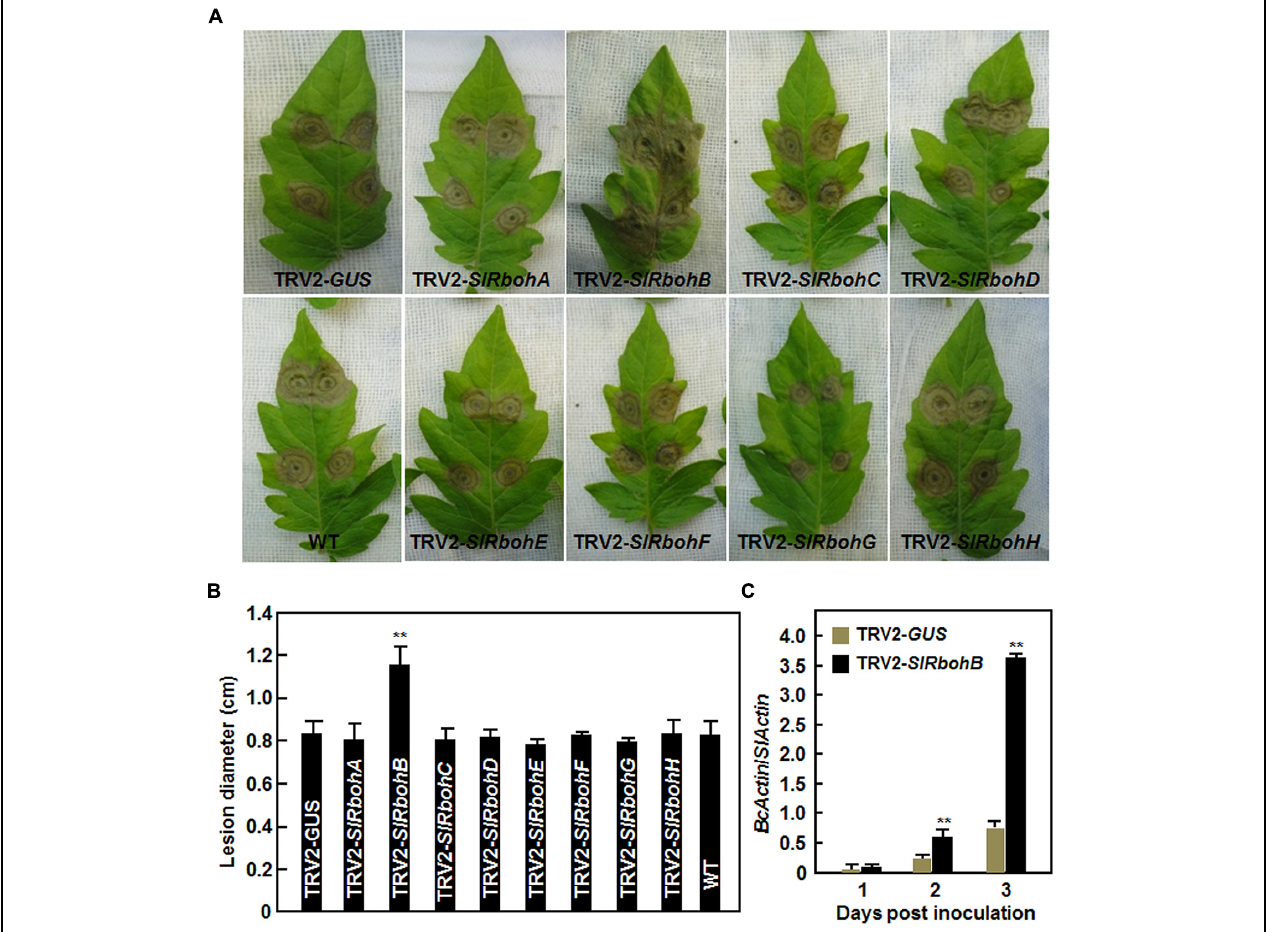
FIGURE 4 | Silencing of SlRbohB led to reduced resistance to B. cinerea . (A) Disease symptom and (B) lesion size. Two-week-old plants were infiltrated with agrobacteria harboring TRV2- SlRbohA–H or TRV2- GUS and leaves were detached for disease assays at 4 weeks after VIGS infiltration. Inoculation was done by dropping spore suspension (1 × 10 5 spores/mL) on detached leaves and lesion sizes were measured at 4 days after inoculation. A minimum of 20